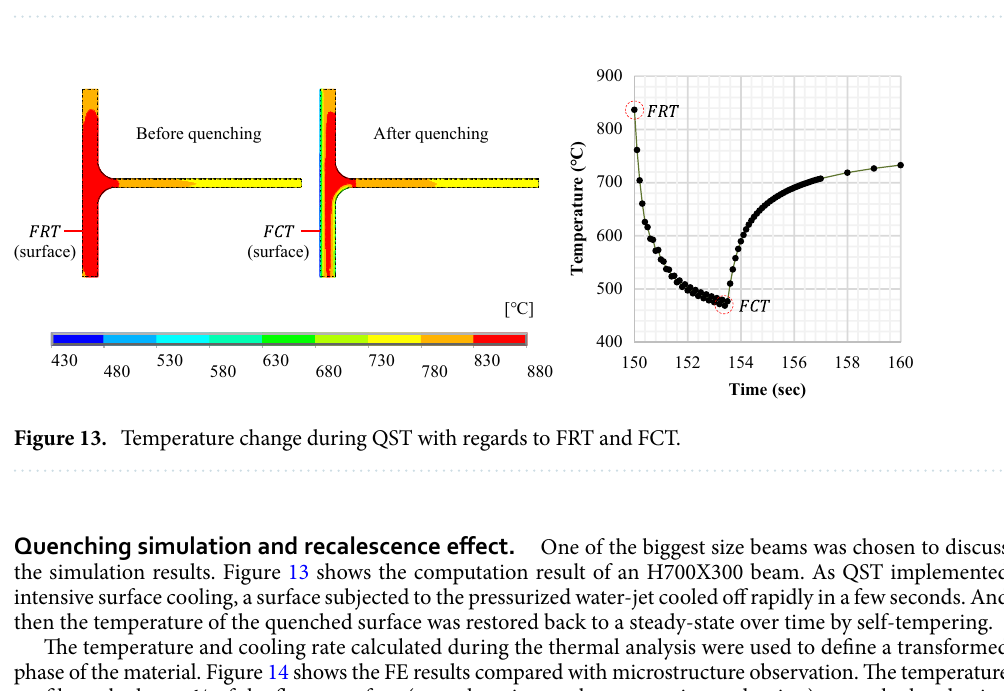
Figure 12. Comparison of FEM suitability with production results adjusted to the regression line.